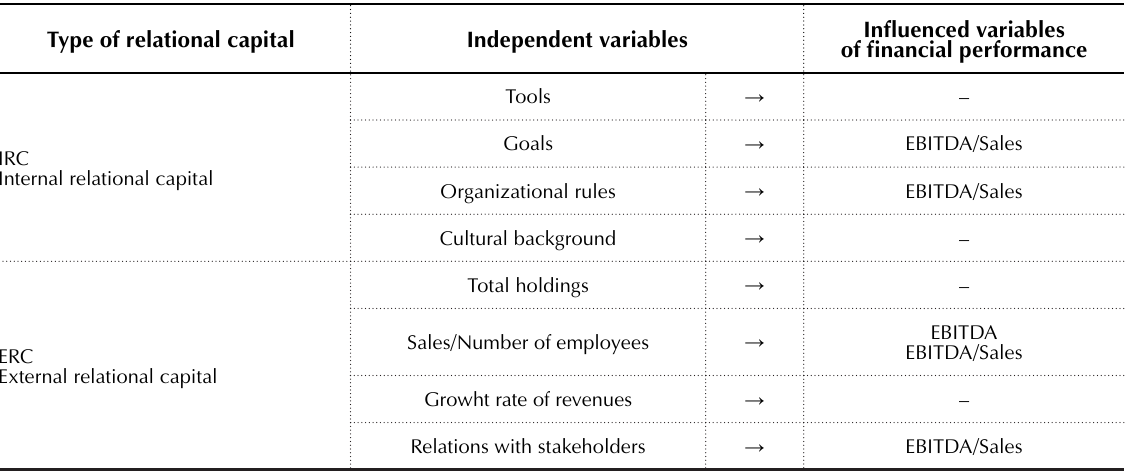
Table 12. Overall regression analysis results